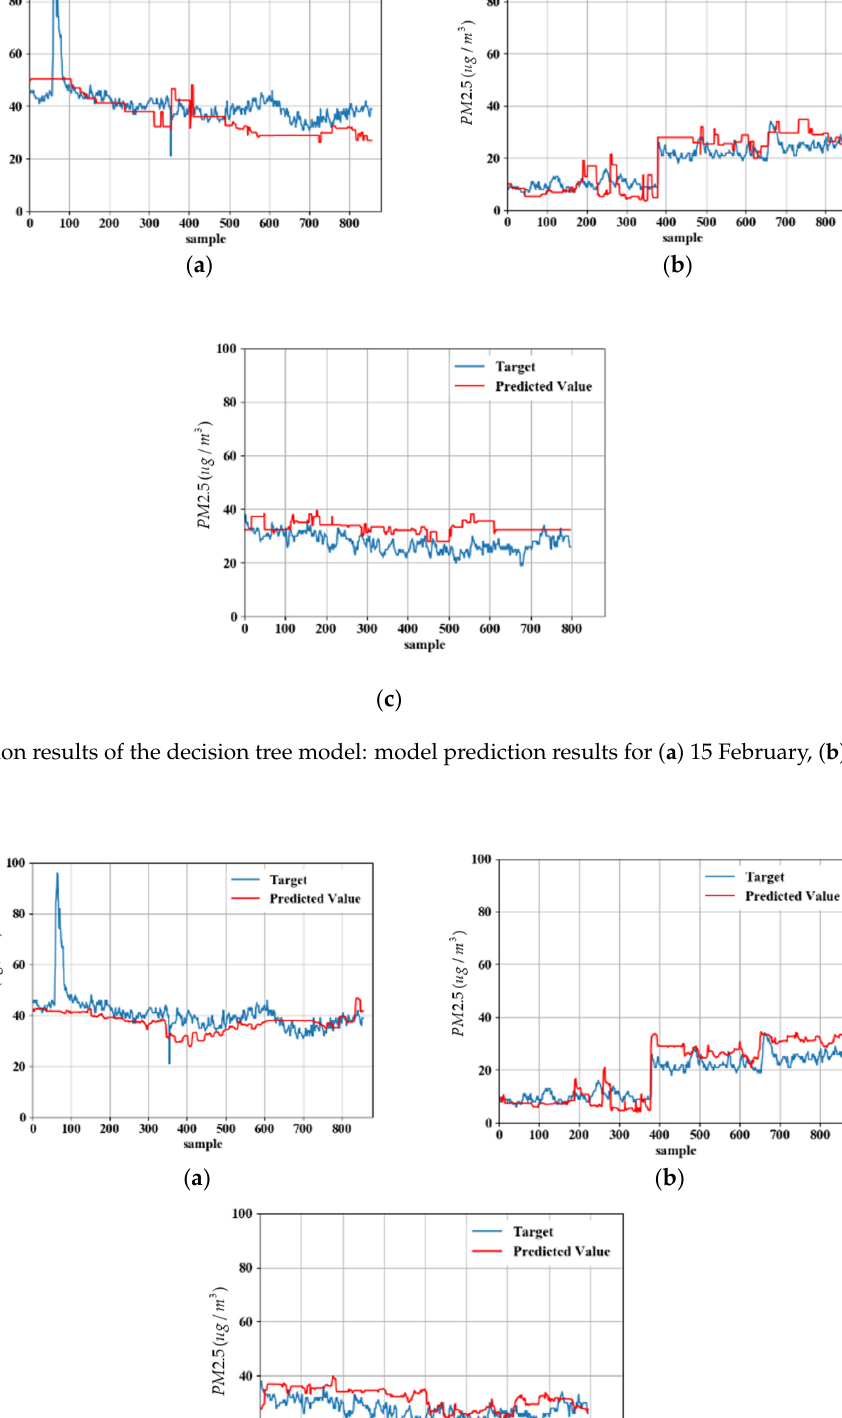
( b ) ( c ) Figure 20. Prediction results of the multilayer perceptron model: model prediction results for ( a ) 15 February, ( b ) 28 Feb- ruary, and ( c ) 1 March 2019.